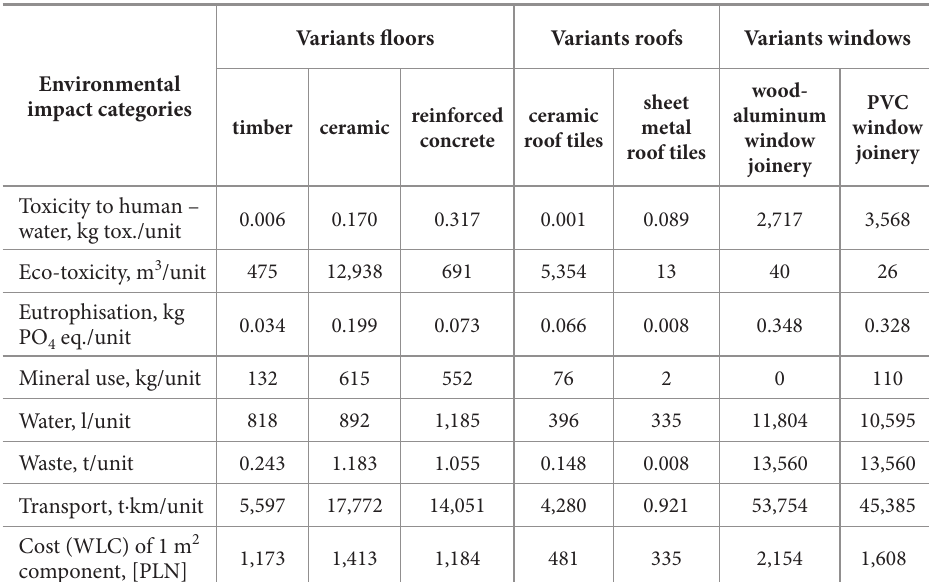
Table 4. Values of environmental impact vectors in the whole life cycle of buildings